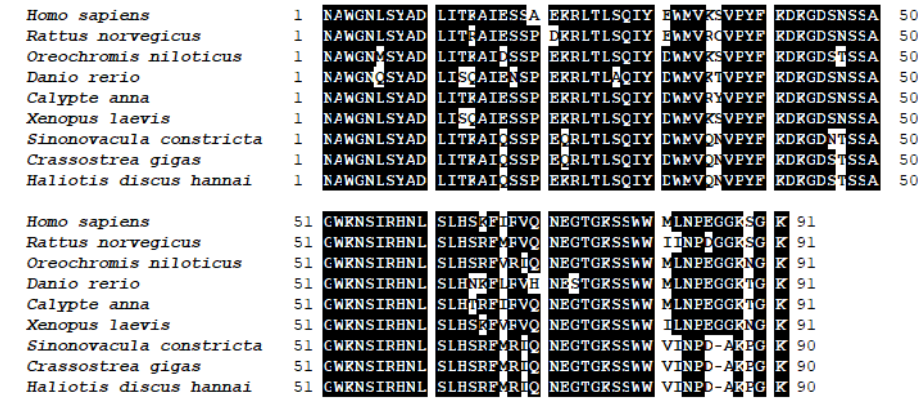
Figure 2. Multiple alignment of amino acid sequence of FH domain from abalone and other organisms. Crassostrea gigas (XP_011414359.1), Sinonovacula constricta (AYW35875.1), Xenopus laevis (NP_001086417.1), Calypte anna (XP_030320236.1), Danio rerio (XP_009289443.1), Oreochromis niloticus (XP_025766550.1), Rattus norvegicus (NP_001099865.1), and Homo sapiens (NP_002006.2). Identical residues are shaded black.